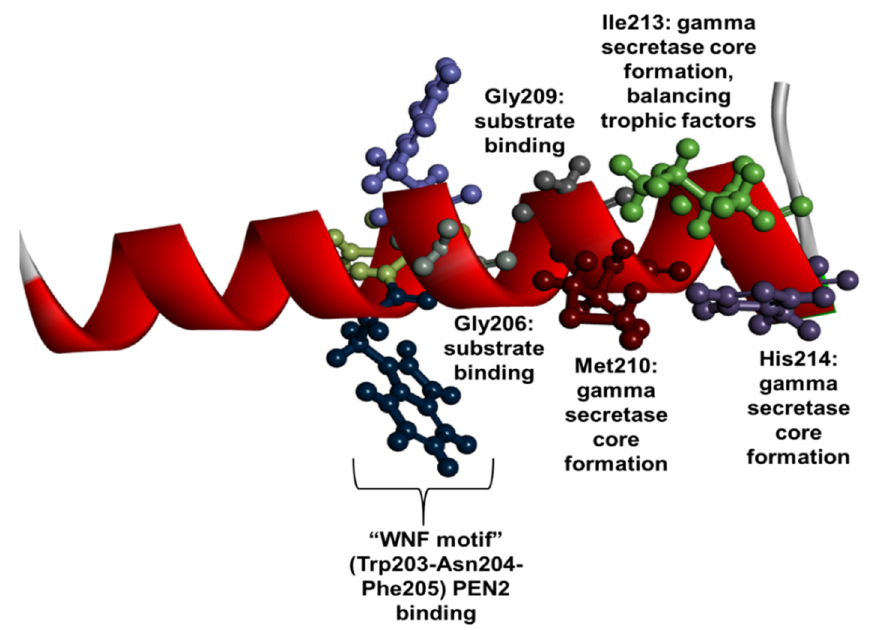
Figure 7. Possible significant residues in